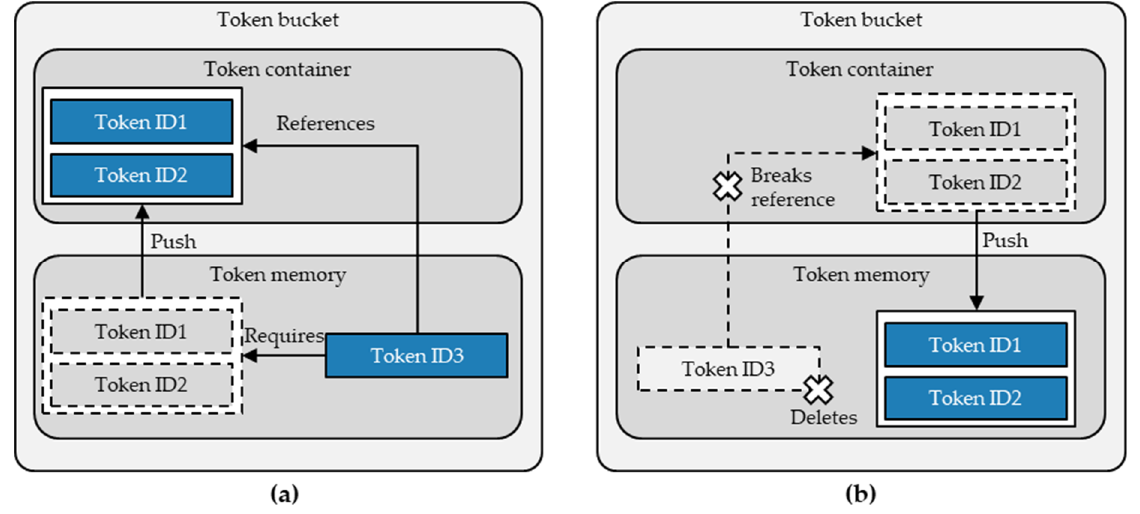
Figure 7. ( a ) Token aggregation mechanism; ( b ) Token disaggregation mechanism.